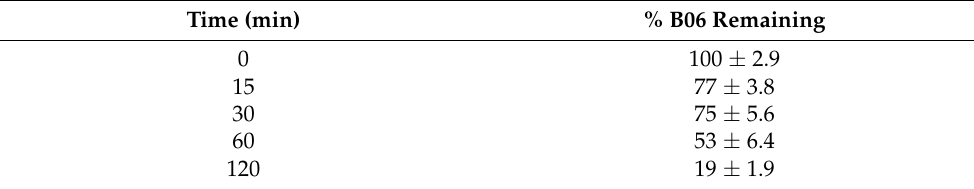
Figure 5. Chemical stability of B06 at pH = 7.4. Table 3. Percentage of B06 remaining at pH 7.4 versus time (0–120